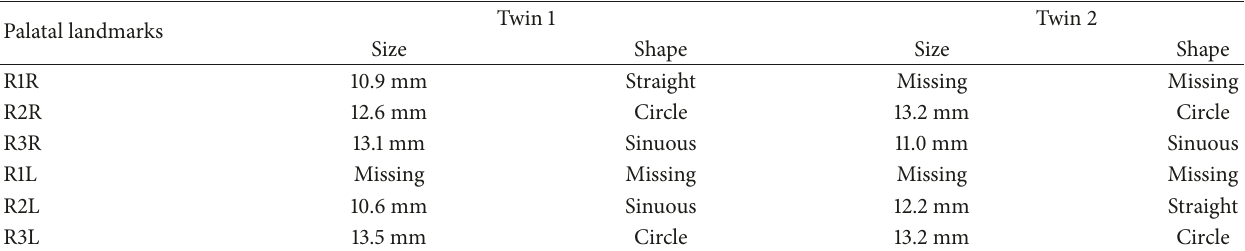
Table 1: Rugae size and shape of the identical twins pair.